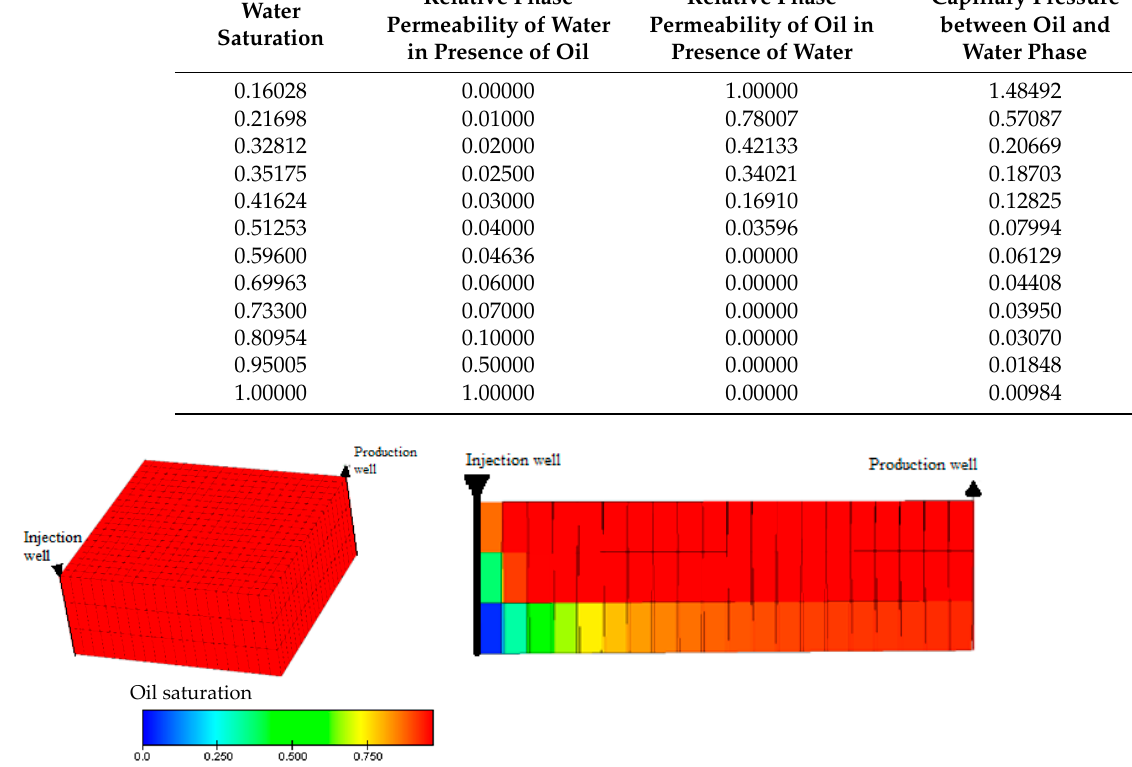
Figure 1. Hydrodynamic model of the site.